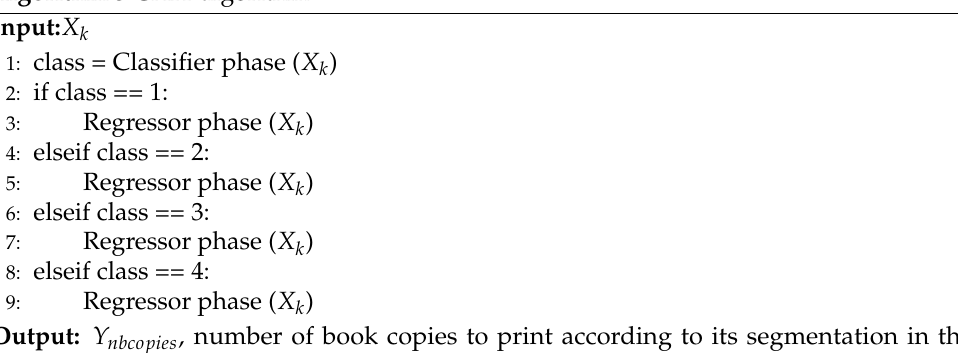
Algorithm 3 CAIT